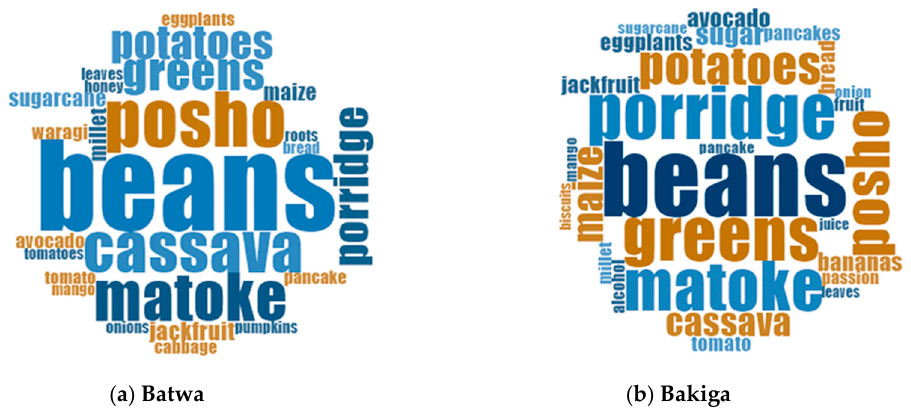
Figure 2. ( a , b ). Word frequency analysis to explore the most eaten foods among Batwa ( a ) and Bakiga ( b ) participants. The bigger the word size, the more times the food item was mentioned during the individual dietary surveys (Scale: 1-50 words). Beans were the foods most commonly eaten in both communities together with matoke (type of banana). Posho and cassava were more consumed among the Batwa, while greens and porridge among the Bakiga.